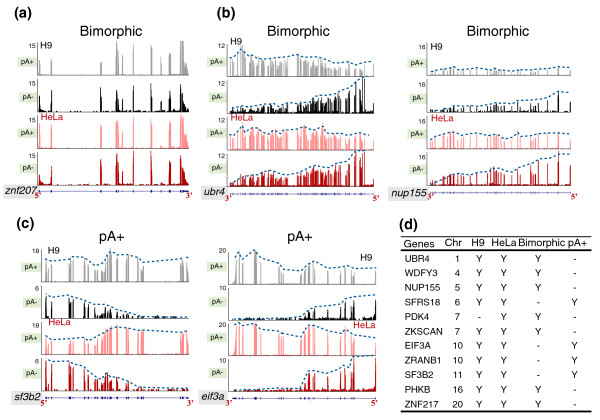
Visualization of incomplete transcripts in the poly(A)- samples. (a) A bimorphic example showing uniform coverage across the complete transcript. Note that the majority of the identified bimorphic transcripts are similar to this. (b) Examples of bimorphic transcripts with non-uniform coverage. Note that both ubr 4 (retinoblastoma-associated factor 600) and nup155 (nucleoporin 155 kDa) show similar normalized read densities in poly(A)+ and poly(A)- samples; however, both exhibit a gradual enrichment toward the 5' ends of the genes (blue dashed lines) in the poly(A)- samples. (c) Examples of non-poly(A)+ transcripts with non-uniform coverage. Note that both sf3b2 (splicing factor 3b, subunit 2) and eif3a (eukaryotic translation initiation factor 3) exhibit a gradual 5' end enrichment (blue dashed lines) in the poly(A)- samples, although both are more abundant in poly(A)+ samples (note the difference in the y-axis). (d) Examples of bimorphic and poly(A)+ transcripts with non-uniform coverage. See text for details.